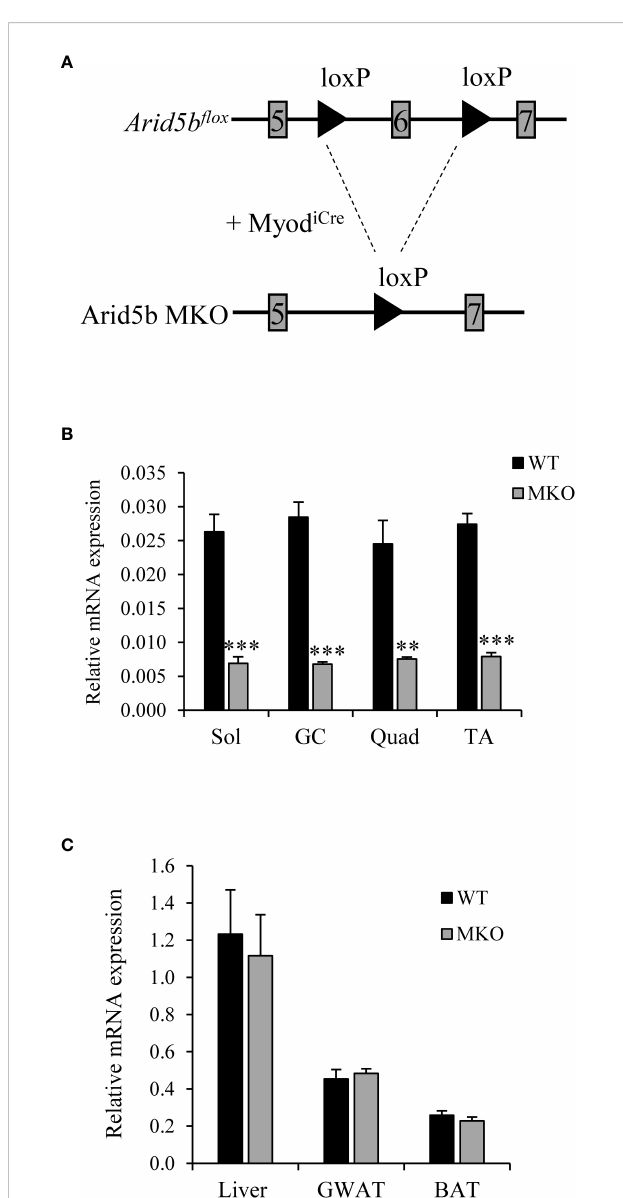
FIGURE 1 Arid5b is deleted speci fi cally in skeletal muscles. (A) Diagram of the knockout strategy used to generate skeletal muscle-speci fi c Arib5b knockout mice. (B) Expression levels of Arid5b in soleus (Sol), gasctrocnemius (GC), quadriceps (Quad), and tibialis anterior (TA) skeletal muscles were determined by quantitative real-time PCR and normalized to Rpl19 mRNA levels. Samples were analyzed in triplicate, and data are expressed as the means ± SE. **, p < 0.01; ***, p < 0.001. (n = 4-8). (C) Arid5b expression levels were analyzed by real-time PCR in liver, GWAT and BAT and normalized to Rpl19 mRNA levels. Samples were analyzed in triplicate, and results are expressed as the means ± SE. (n =